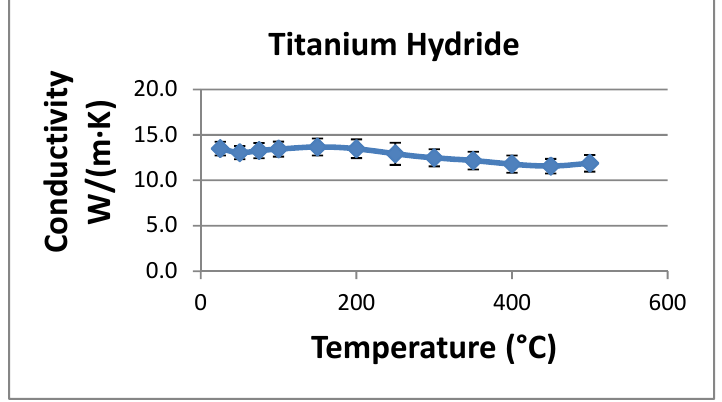
Figure 5. Thermal conductivity up to 500 °C of three different titanium samples; Ti from University of Utah, Ti-sponge and ITP- Ti (International Titanium Powder).